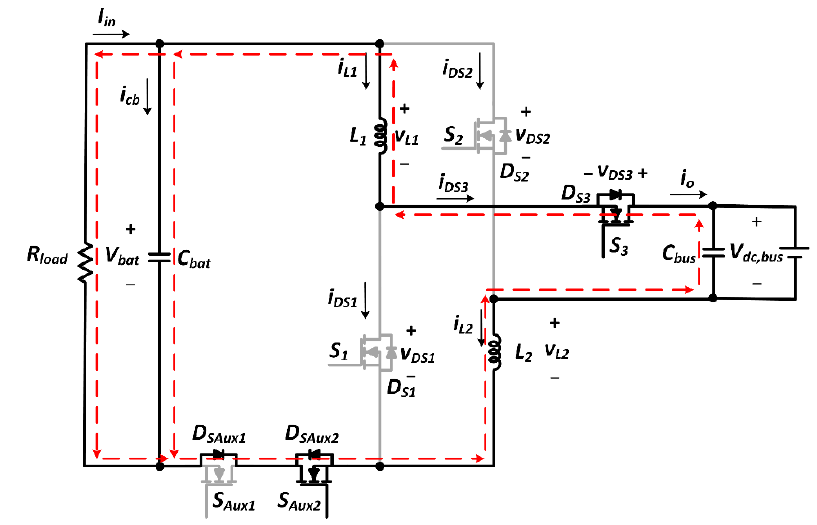
Figure 7. The current flow paths of step-down mode i .